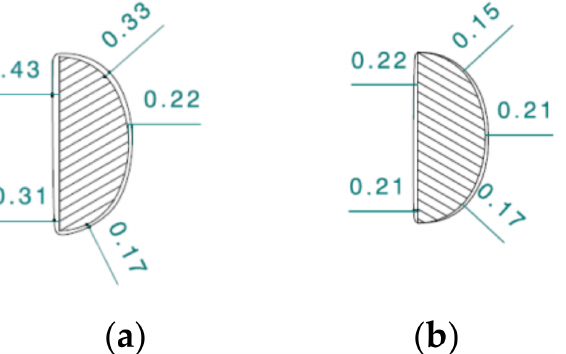
Figure 15. Shape error in cross-section of the forceps arm after: ( a ) manual grinding and ( b ) grinding with the use of